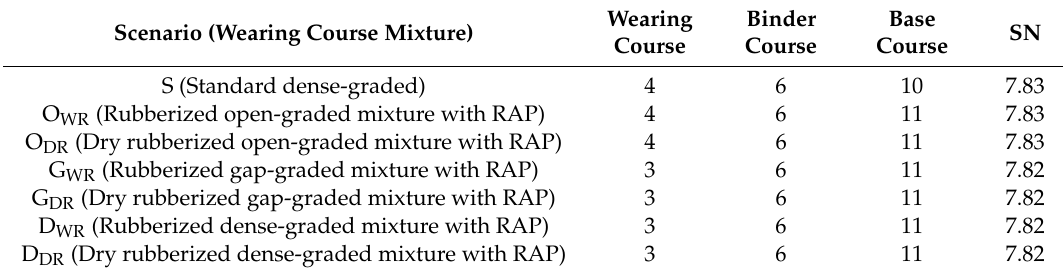
Table 1. Thickness of the asphalt layers